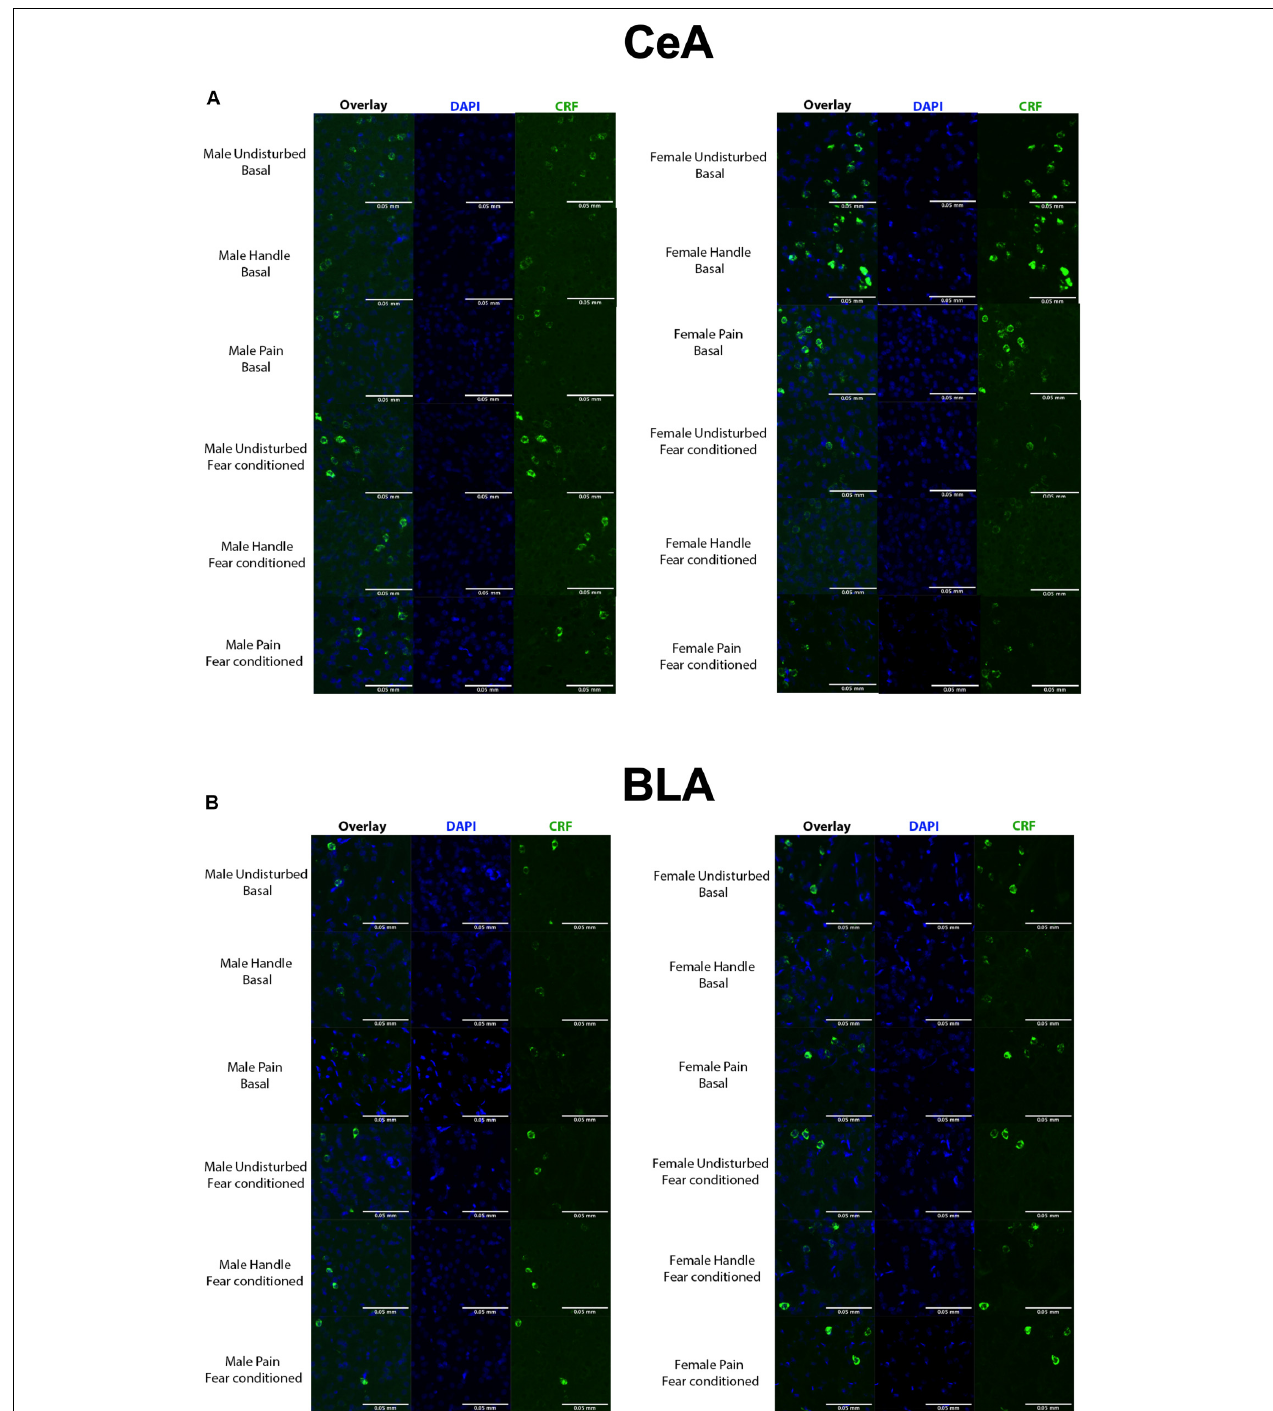
FIGURE 4 | (A) Quantified FISH image samples from each represented group within the CeA. Green = CRF, blue = DAPI. (B) Quantified FISH image samples from each represented group within the BLA. Green = CRF, blue = DAPI. N’s ranged 4–7 subjects per group.